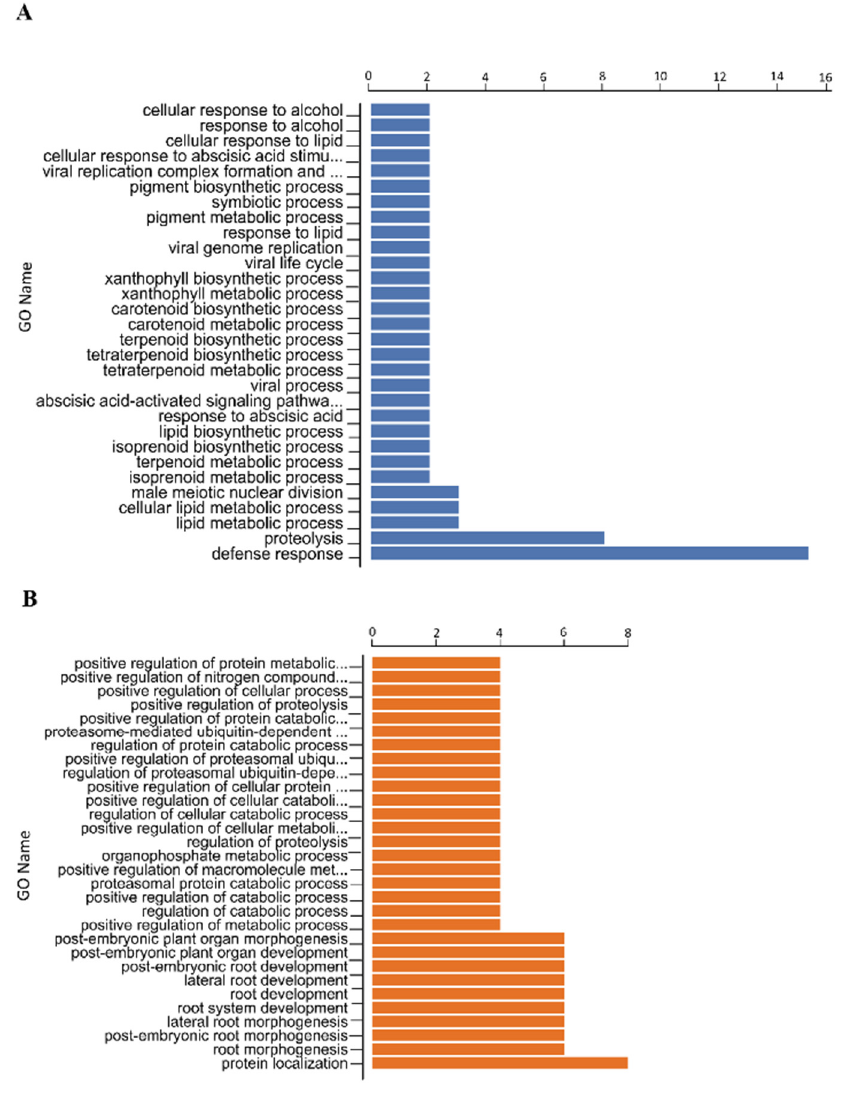
Figure 6. GO enrichment analysis in tree tomato A21 ( A ) and A23 ( B ) transcriptomes.